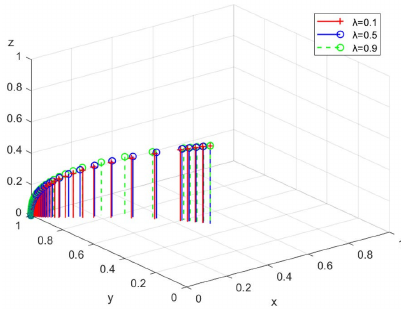
Figure 7. The path under different fines.